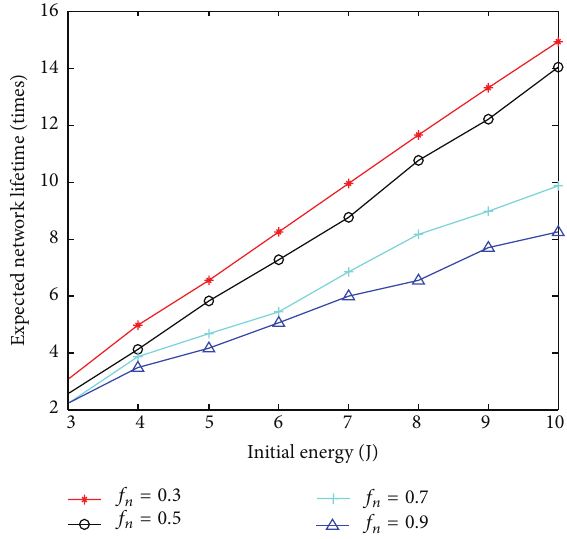
Figure 4: Expected lifetime for optimal lifetime with different weighting